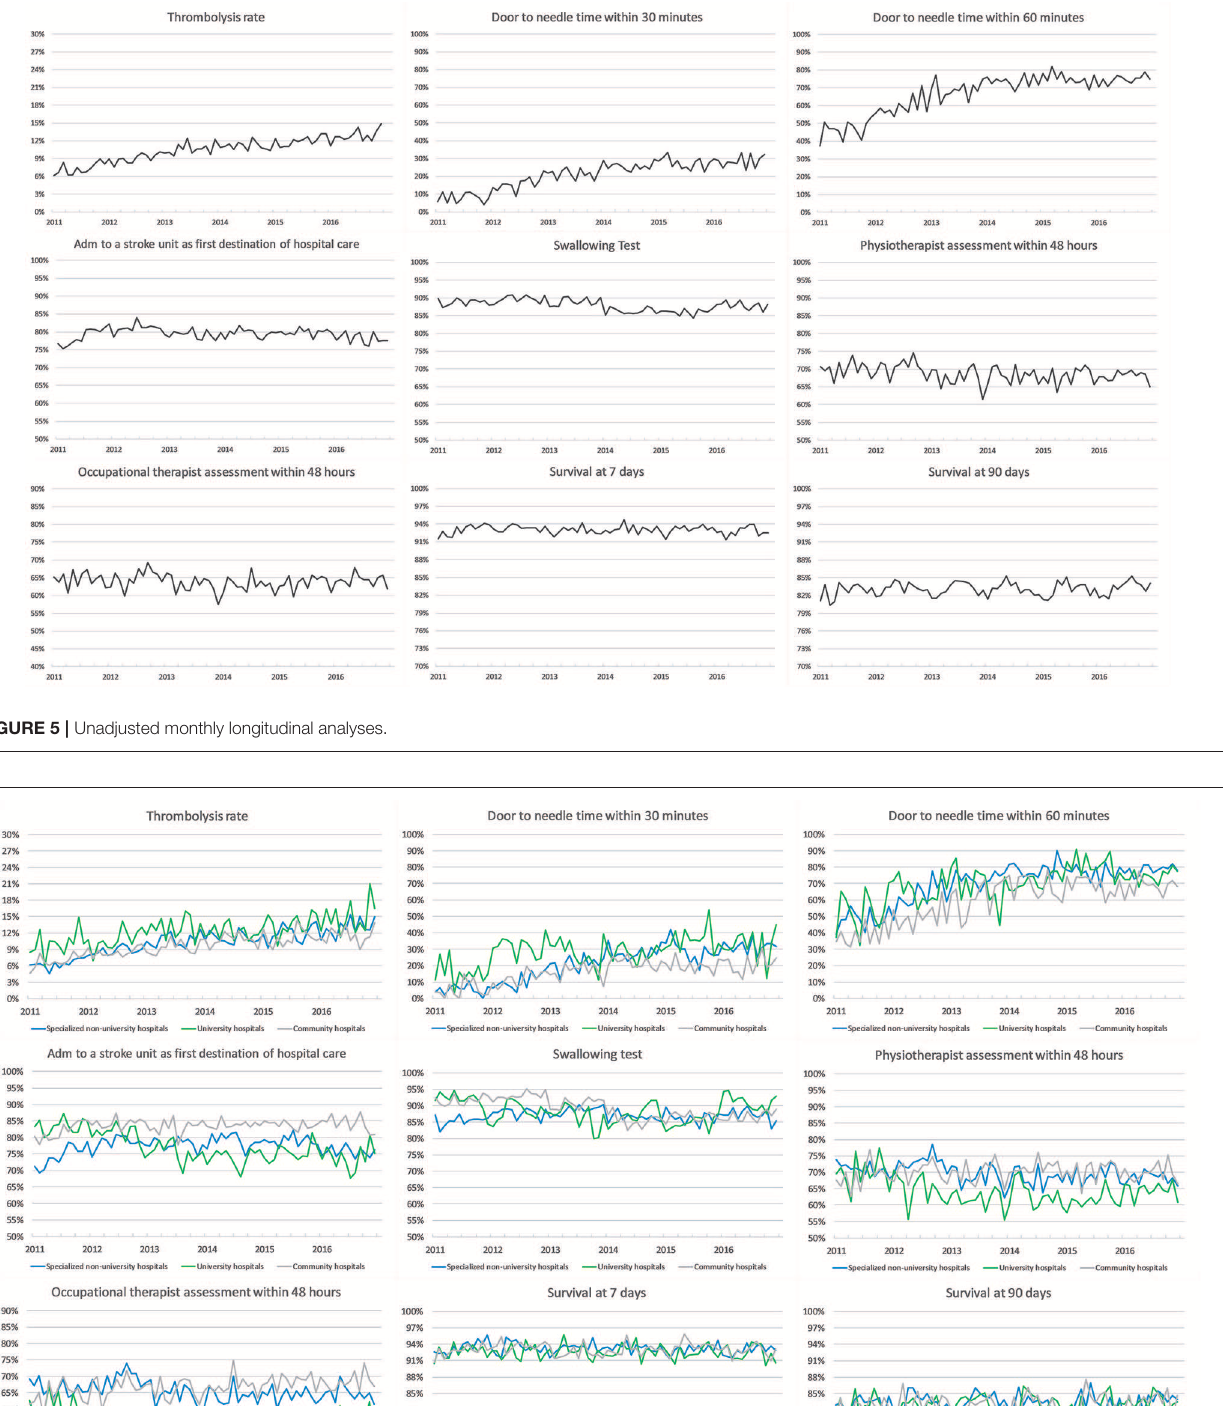
Frontiers in Neurology | www.frontiersin.org